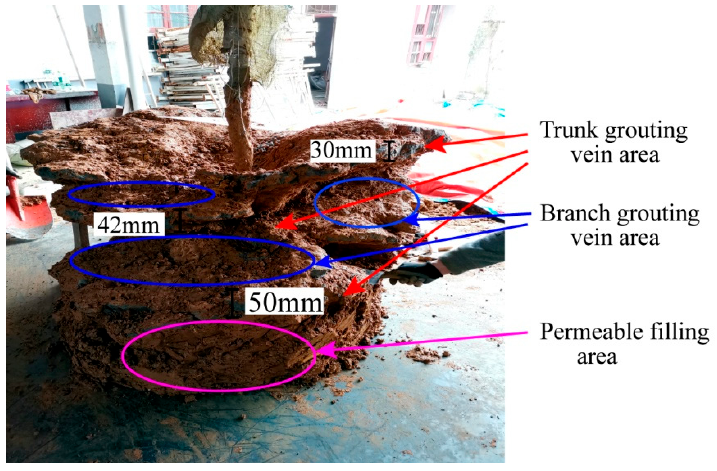
Figure 9. Distribution characteristics of grouting veins.